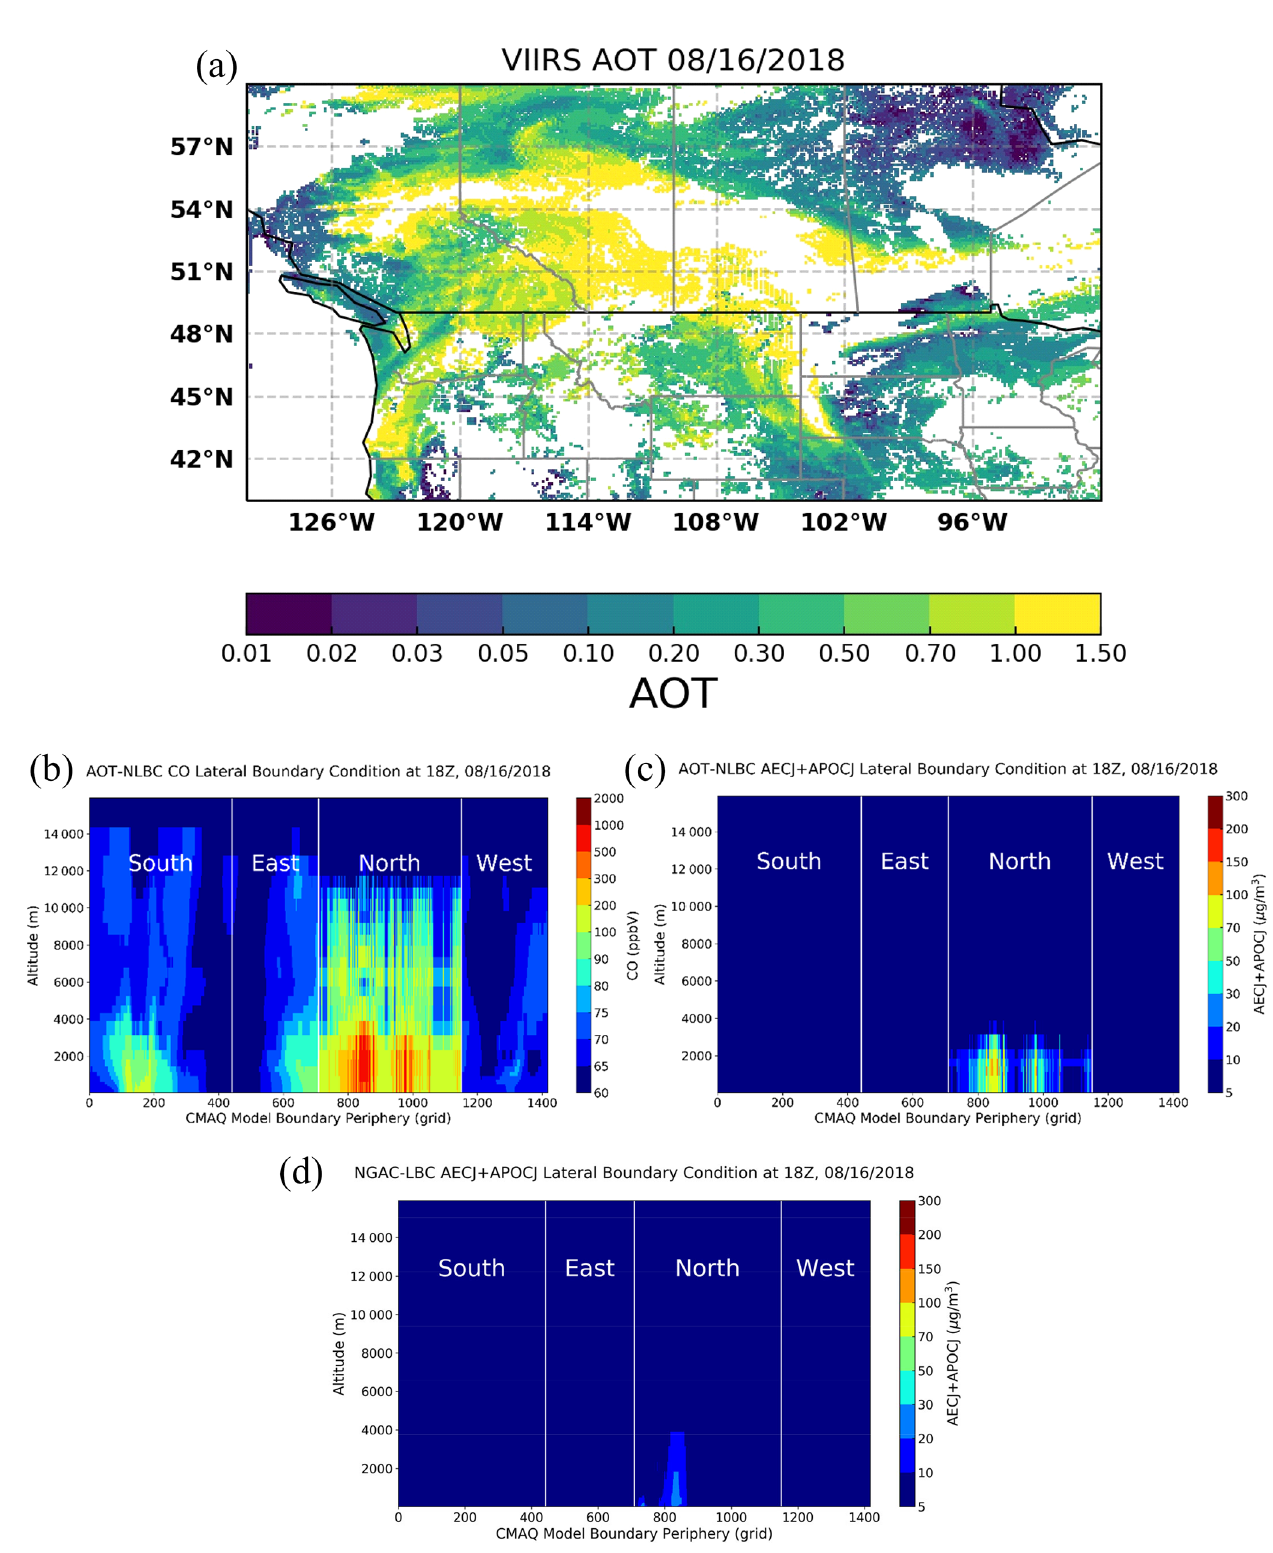
Figure 12. VIIRS-AOT (a) on 16 August 2018 and the corresponding derived AOT-NLBC for CO (b) and AECJ + APOCJ (c) . Plot (d) shows NGAC-LBC’s AECJ + APOCJ at the same